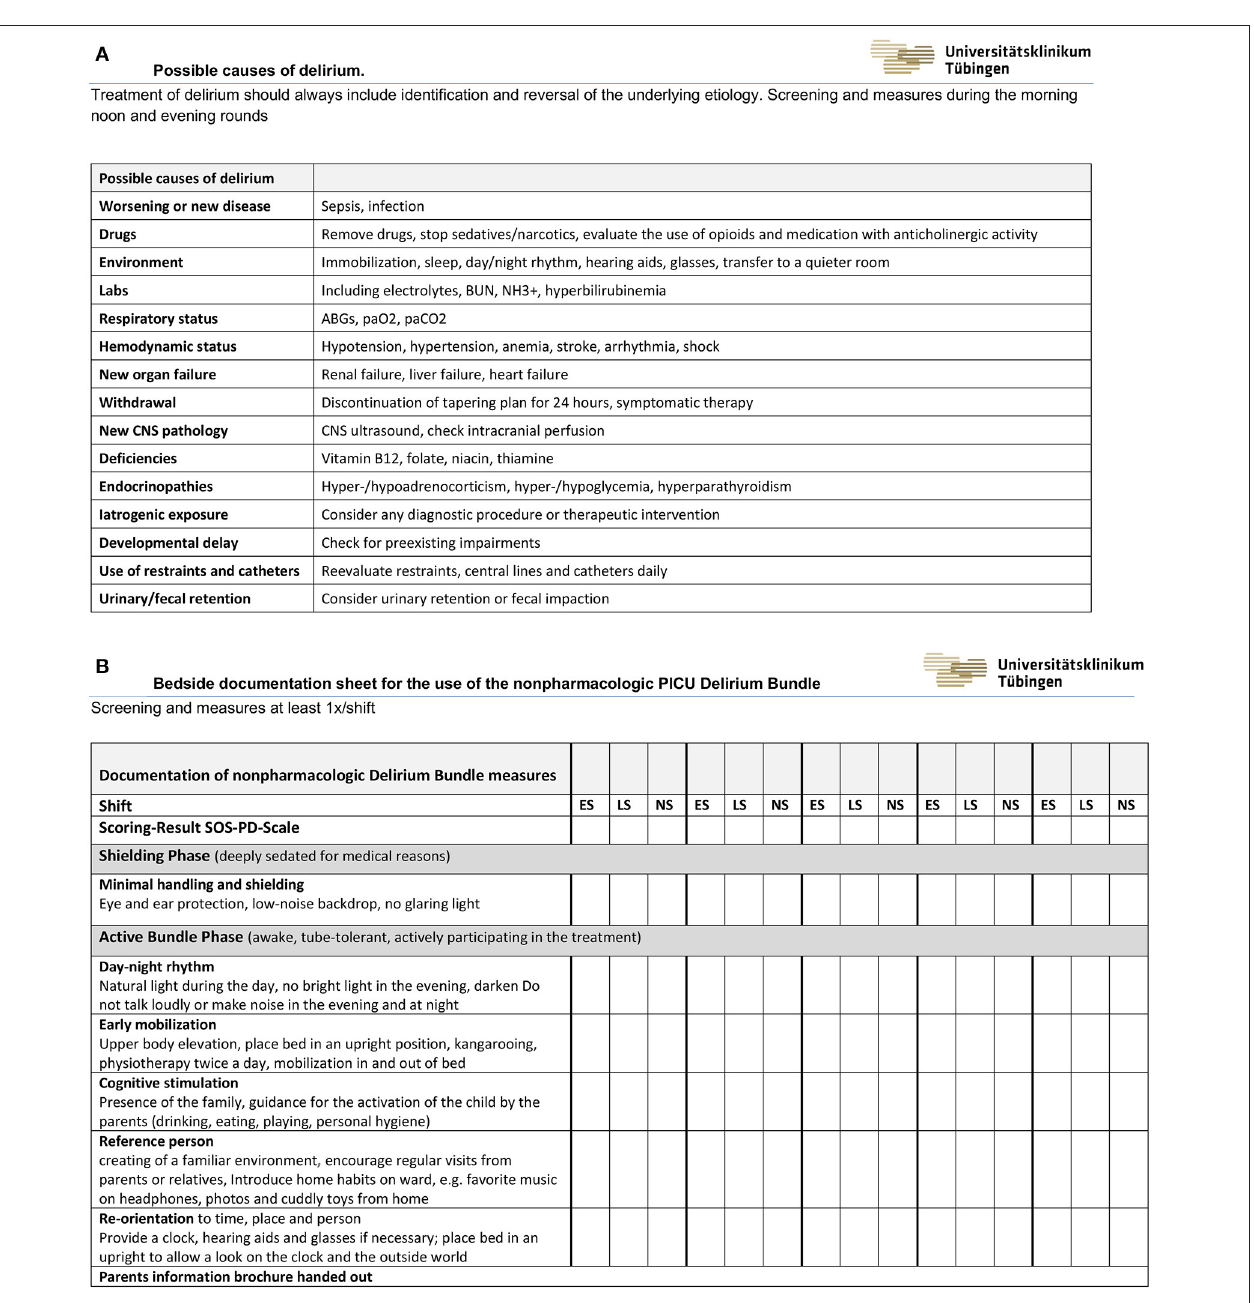
FIGURE 2 | (A) Possible causes of pediatric delirium. (B) Bedside checklist and documentation sheet for the non-pharmacologic measures of the PICU Delirium Bundle (ES, Early Shift; LS, Late Shift; NS, Night